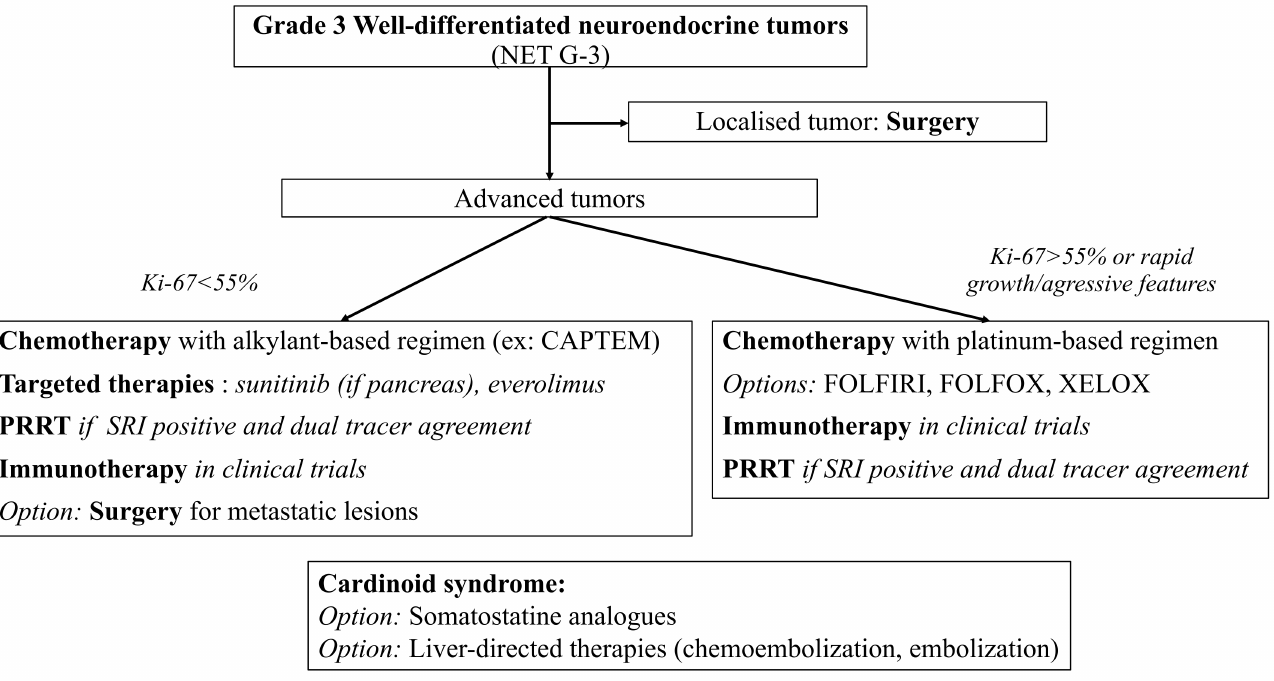
Figure 3. Proposed treatment algorithm for the therapeutic management of grade 3 well-differentiated neuroendocrine tumors (NET G-3). CAPTEM: capecitabine + temozolomide, FOLFIRI: 5-fluorouracile + irinotecan, FOLFOX: 5-fluorouracile + oxaliplatine, XELOX: capecitabine + oxaliplatine, PRRT: peptide receptor radionuclide therapy, SRI: somatostatin recep- tor